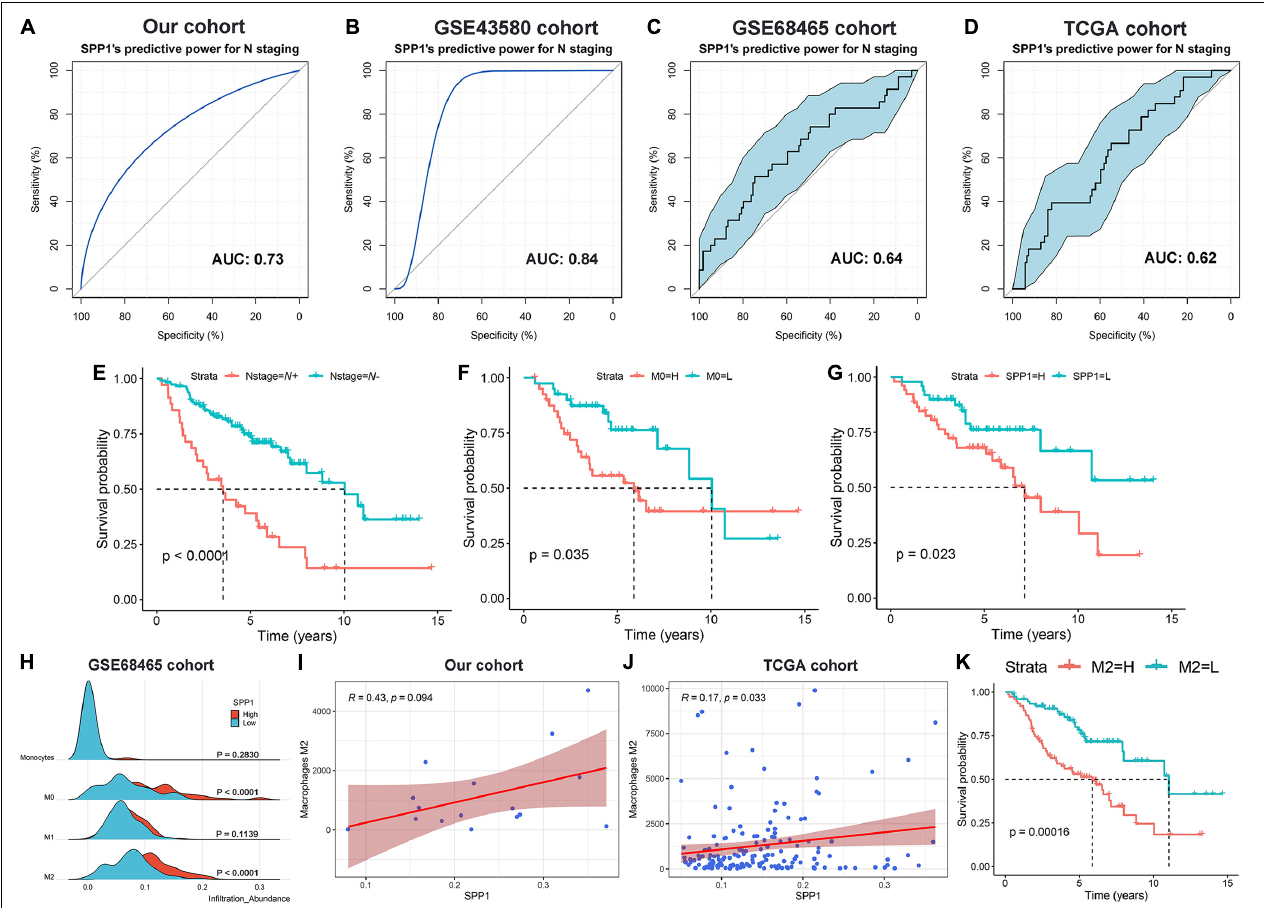
FIGURE 6 | Analysis of SPP1 for the prediction of lymph node metastasis and influence on the long-term survival of Stage-T1 LUAD patients. The receiver operating curve (ROC) and area under the curve (AUC) were used to evaluate the predictive power of SPP1 for early lymph node metastasis in our cohort [ (A) n = 16], GSE43580 cohort [ (B) n = 20], GSE68465 cohort [ (C) n = 149] and TCGA cohort [ (D) n = 165]. Kaplan–Meier curves of overall survival for patients with distinct N stages (E), M0 infiltration (F), and SPP1 expression (G) . (H) Multipeaked mountain map displaying the infiltration abundance divergence among the monophagocytic system (Monocytes, M0, M1, and M2) across groups with different levels of SPP1 expression in GSE68465 cohort. The correlation analysis of M2 infiltration and SPP1 expression in our cohort (I) and TCGA cohort (J) . (K) Kaplan–Meier curve to evaluate the influence of M2 infiltration on the OS in patients with Stage-T1